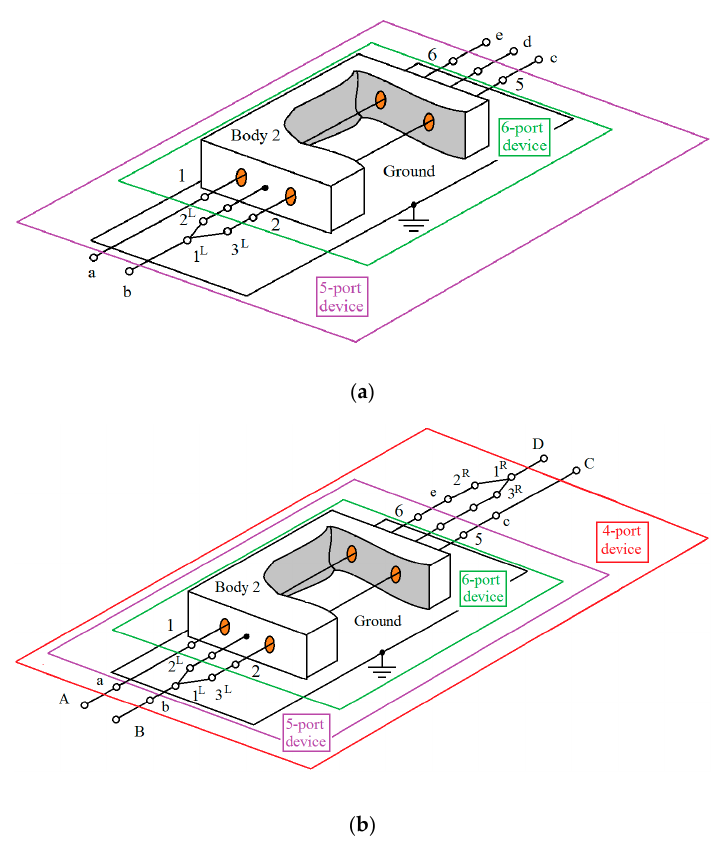
Figure A1. The six-port reentrant section on the base of body “2” placed above the ground: ( a ) after connection of the left three-port device, ( b ) after the connection of the right one.